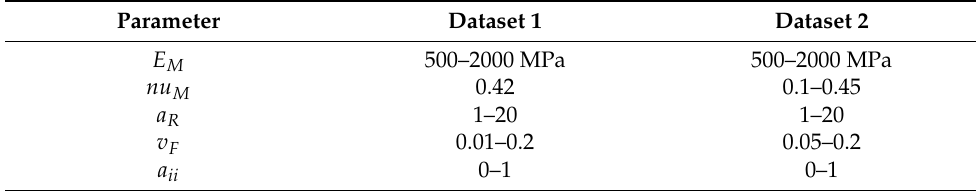
Table 1. Range of the parameters of the two datasets. Parameter Dataset 1 Dataset 2 E